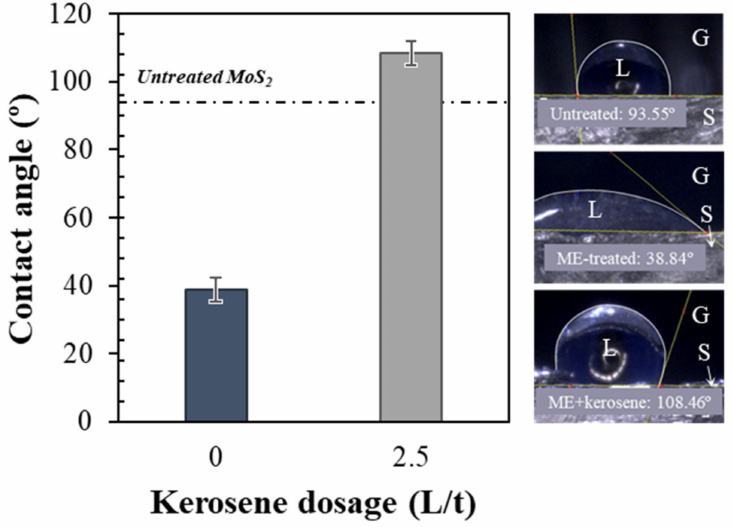
Figure 6. Effect of kerosene dosage on the contact angle of ME-treated molybdenite. Note that G, L, and S on the right side of the photos indicate gas (air), liquid (water droplet), and solid (molybdenite) phases,